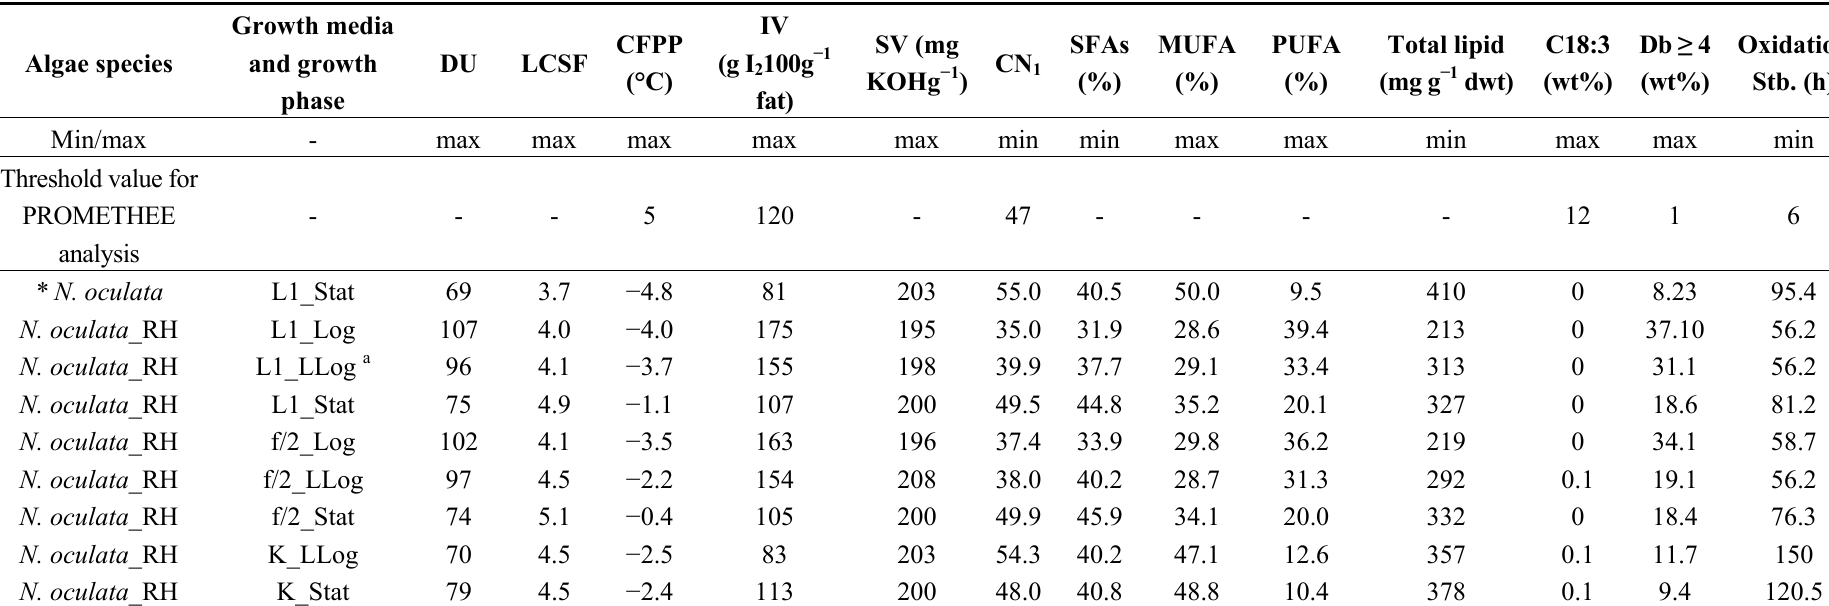
Table 4. Effect of growth phase and cultivation media on biodiesel properties calculated from the FAME profile, total lipid, saturated fatty acids (SFAs), mono-unsaturated fatty acids (MUFA) and polyunsaturated fatty acids (PUFA) contents of Nannochloropsis oculata . Algae